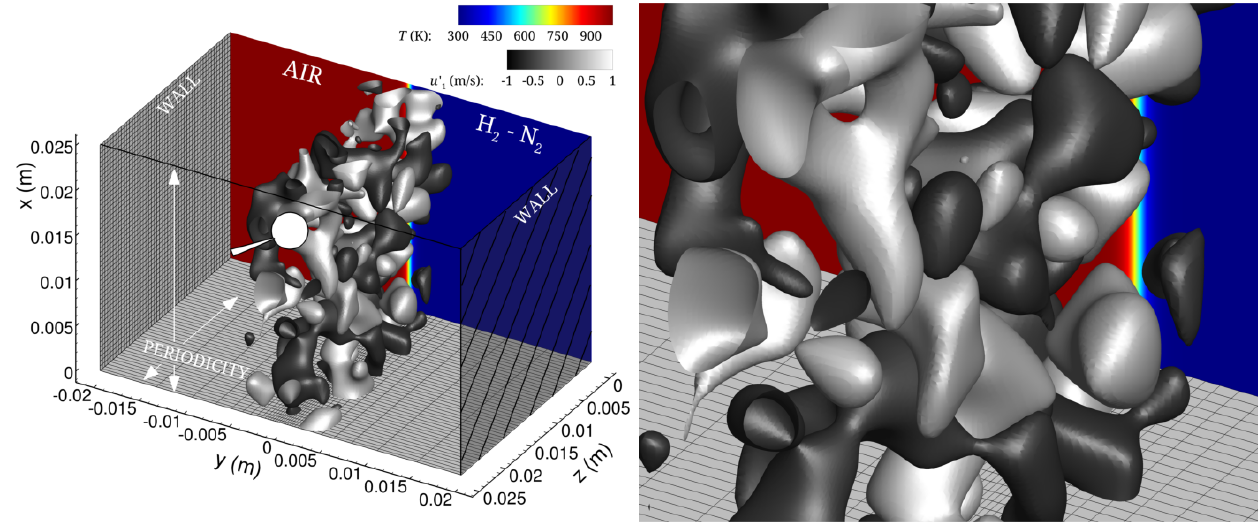
Figure 1. Stationary mixing layer problem: the computational domain and mesh (grid lines are drawn every four at the side boundary); initial temperature (contours at the side boundary) and anisotropic turbulent field (iso-surfaces of u (cid:48)